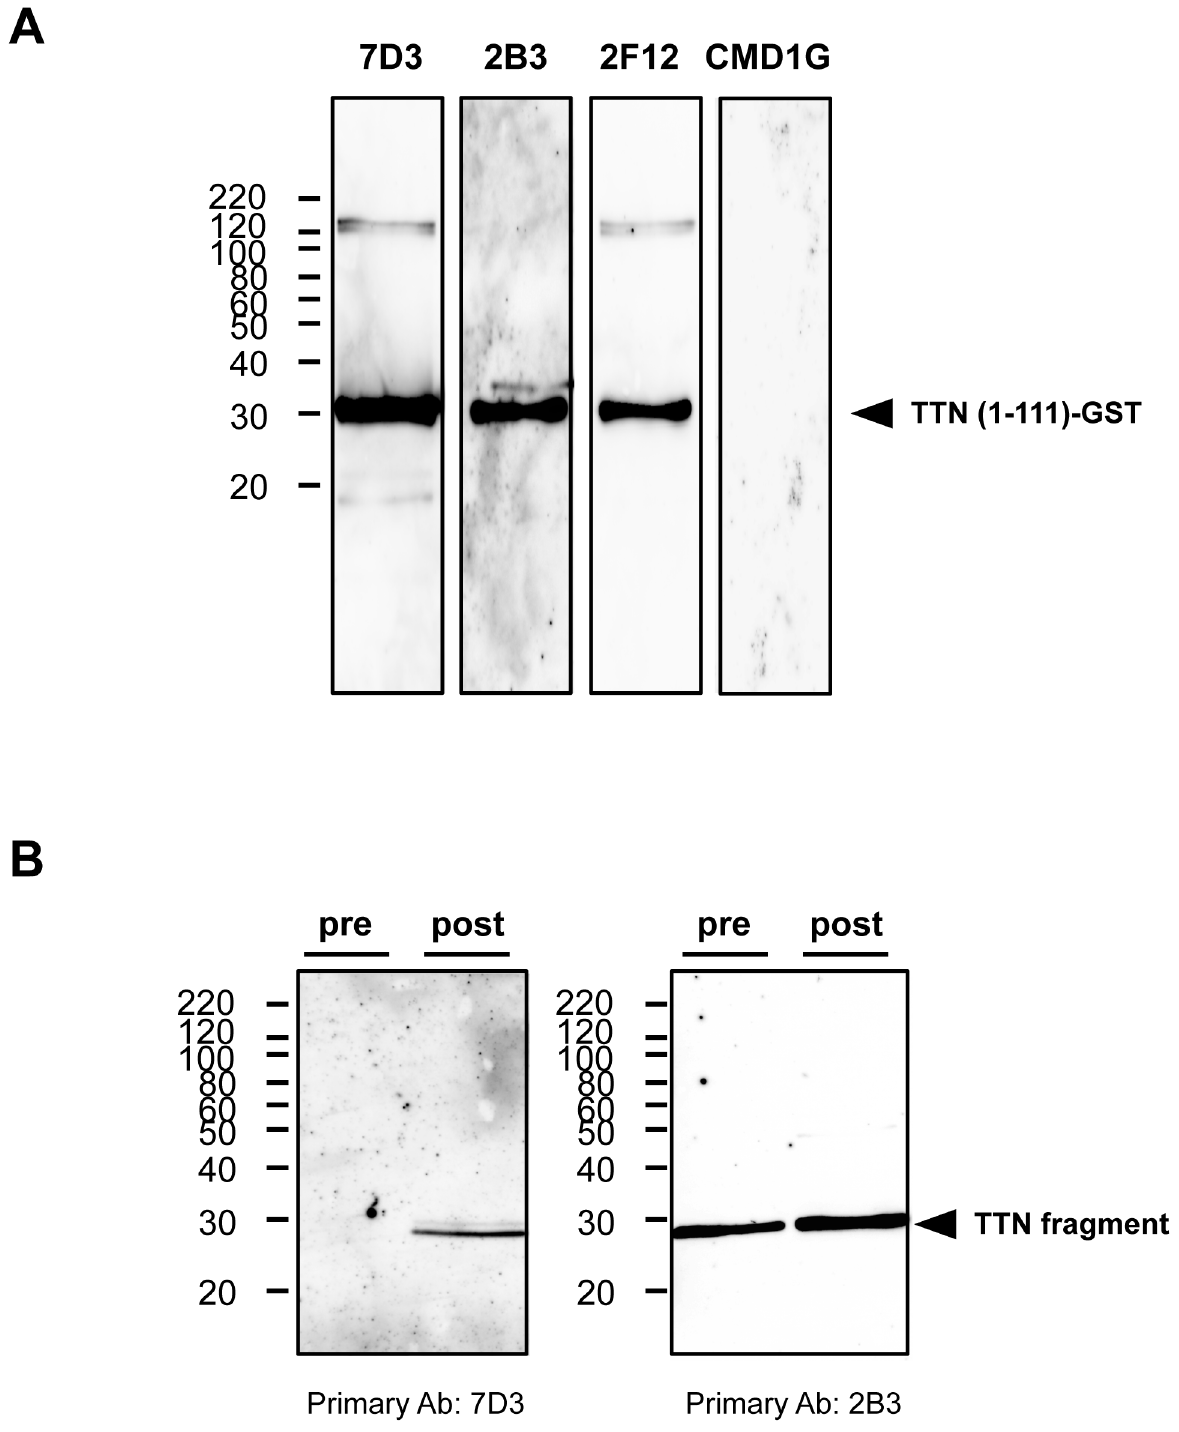
Fig 3. Reactivities of antibodies against the N-terminal fragment of human titin. (A) To identify antibodies that react with the N- terminal fragment of humantitin, a recombinant humantitin fragment (amino acids1–111)was loadedonto an SDS-PAGE gel, and the antibody reactivitieswereevaluatedwith immunoblotting usingan appropriatesecondary antibody.Anti-human titin antibodyclones7D3 (1:1000), 2B3 (1:1000), and2F12 (1:1000)detectedthe recombinant titin protein. Anti-human titin antibodyCMD1G (1:500)did not detect the protein.The arrowheadindicatesthe GST-taggedrecombinanthumantitin (aminoacids 1–111).(B) To confirm the reactivities of the antibodies, urine samples(pre and post: beforeand 96 hours after the eccentric exercise, respectively) were loadedonto an SDS-PAGE